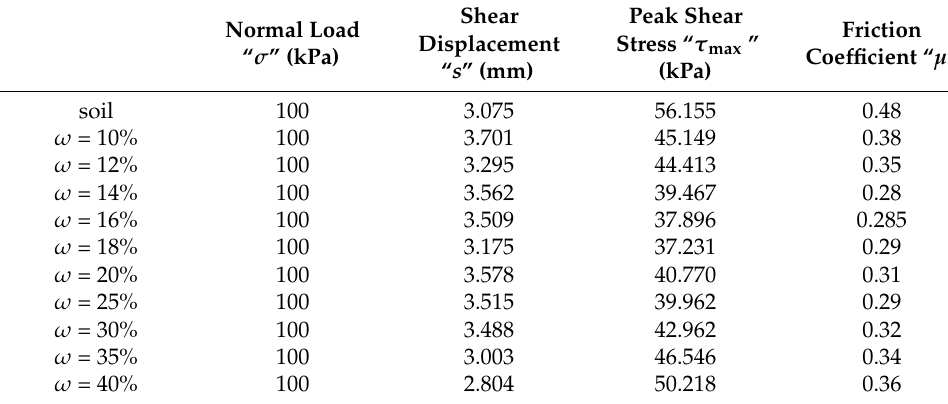
Table 2. Friction test data of the pipe–soil interface with different